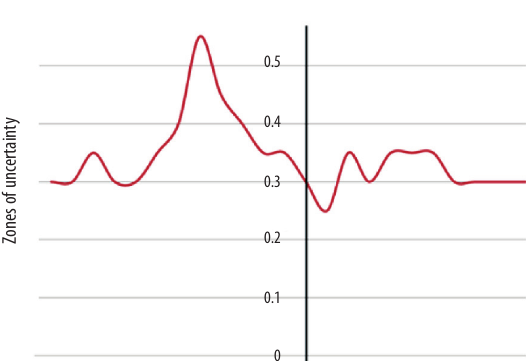
Fig. 6. Dependence of zones of uncertainty on angle of attack